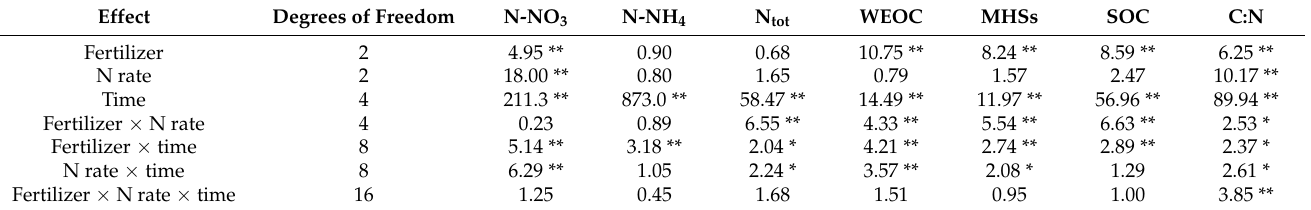
Table 2. Analysis of variance of fertilizer type, N rate, and soil collection time effects on soil quality characteristics during wheat growth (the table shows the sources of variation and probability for the F -test of each factor and its